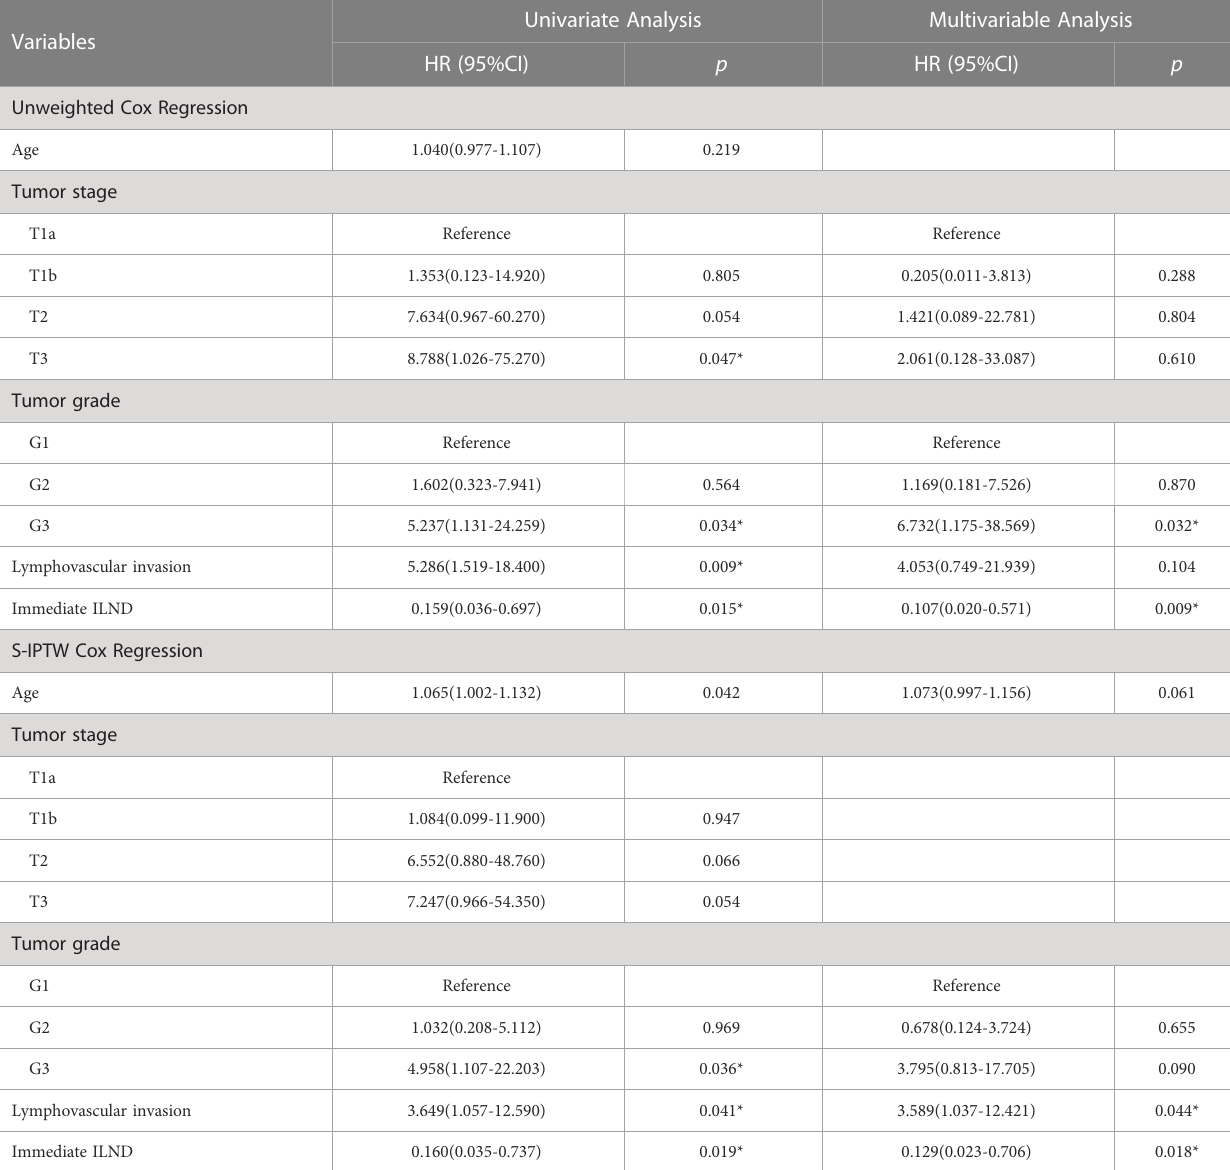
TABLE 3 Univariate and multivariable Cox regression in 87 cN0 penile cancer patients who underwent either immediate ILND or delayed ILND, with unweighted and S-IPTW adjustments.